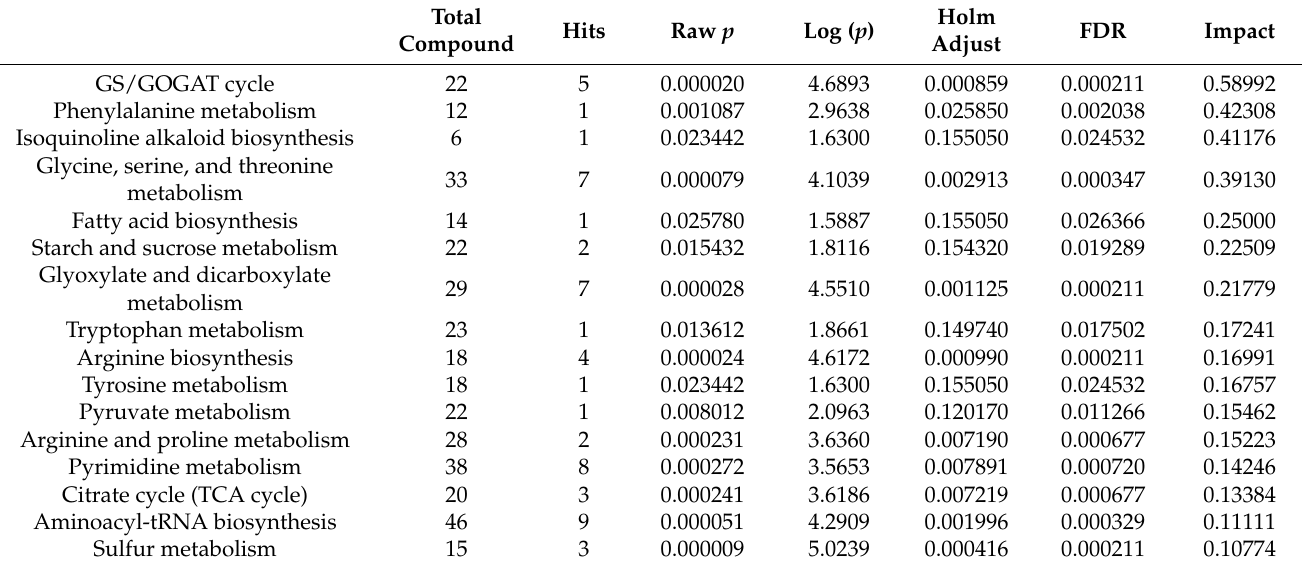
Table 4. Pathway enrichment analysis depicting significantly altered metabolic pathways in L. chinensis in response to alkali stress.